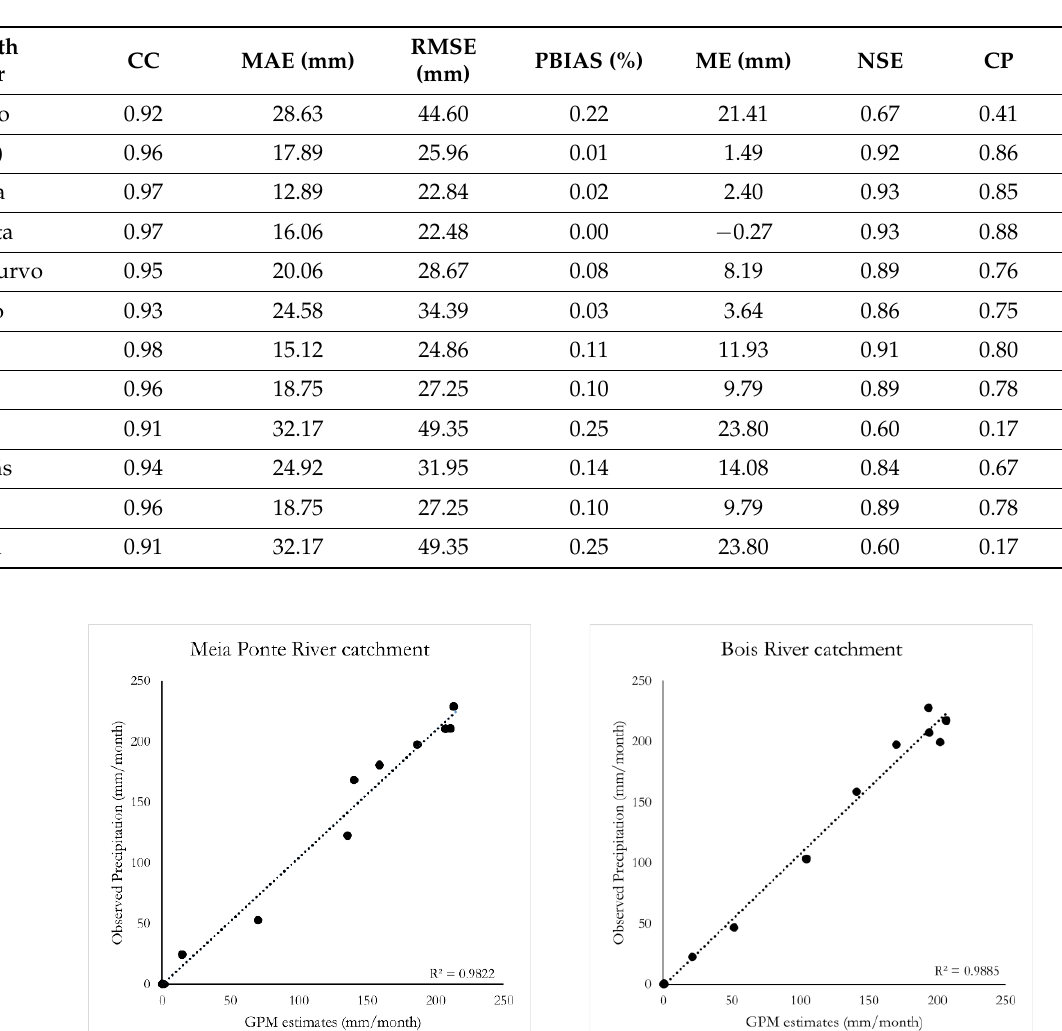
Table 8. Goodness-of-fit metrics for monthly precipitation data from 12 gauging stations located in the Bois River catchment.